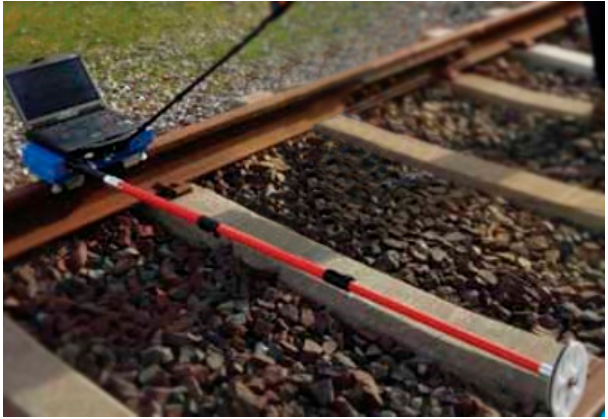
Figure 3. RailMeasurement’s CAT [41].